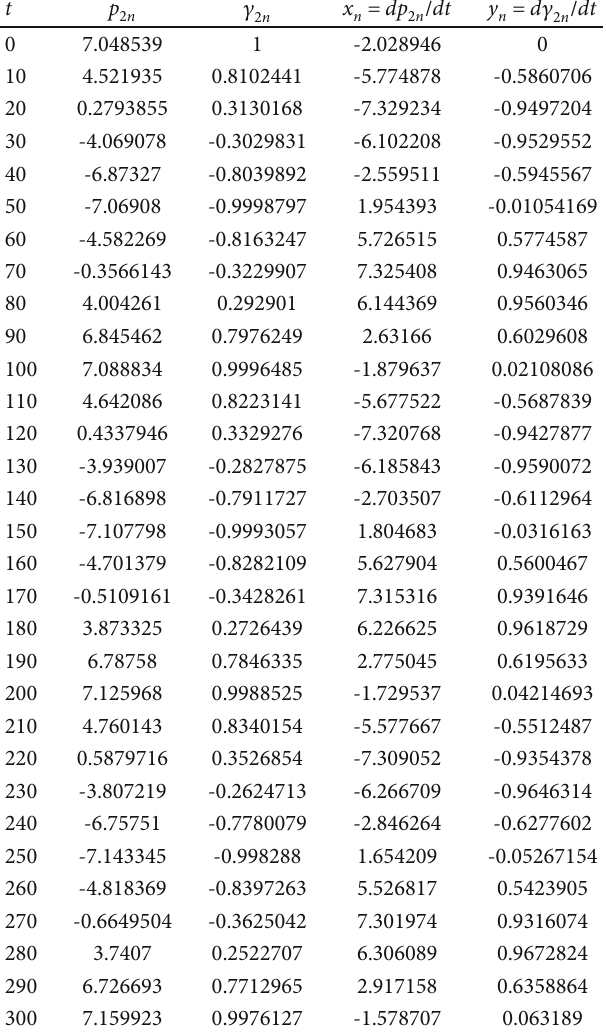
Table 2: The values of numerical solutions in the interval t ∈ ½ 0, 300 (cid:2)